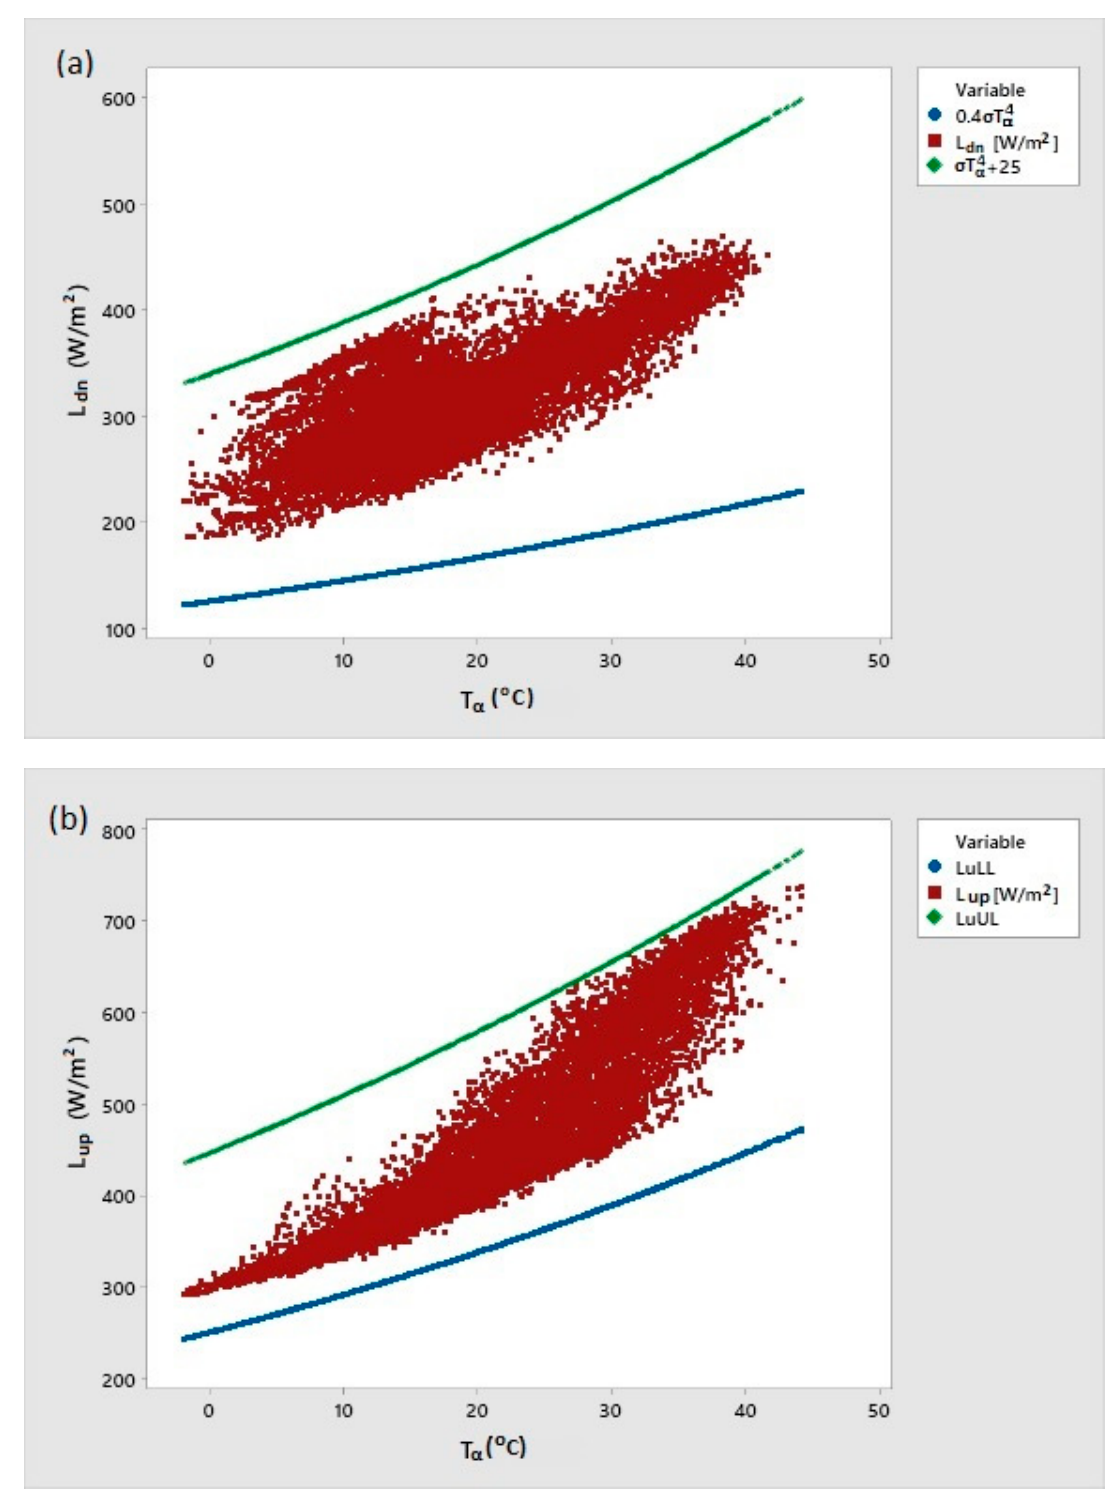
Figure 4. ( a ) Downward and ( b ) Upward longwave irradiance testing versus air temperature (Global cross-comparisons, Equations (4) and (5)). Green represents the upper limit and blue the lower limit.